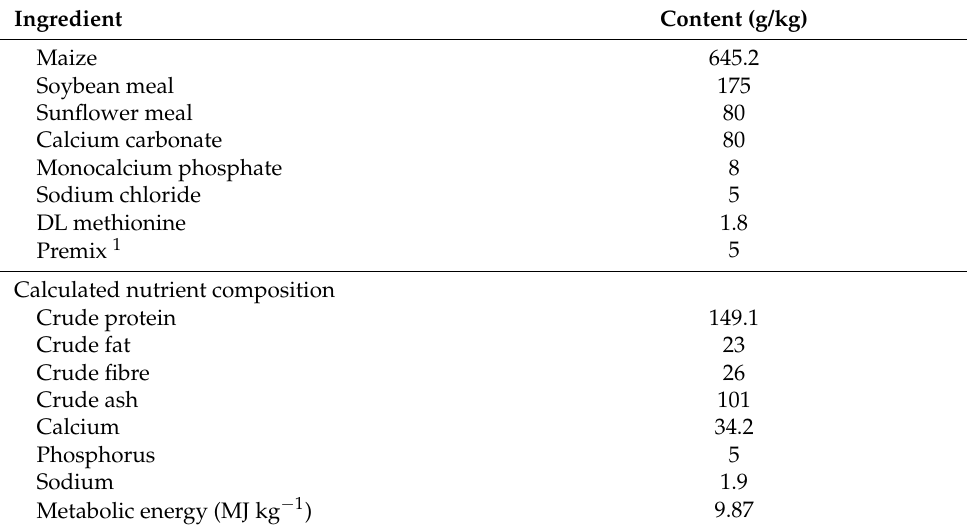
Table 1. Standard diet feed composition and calculated nutrient